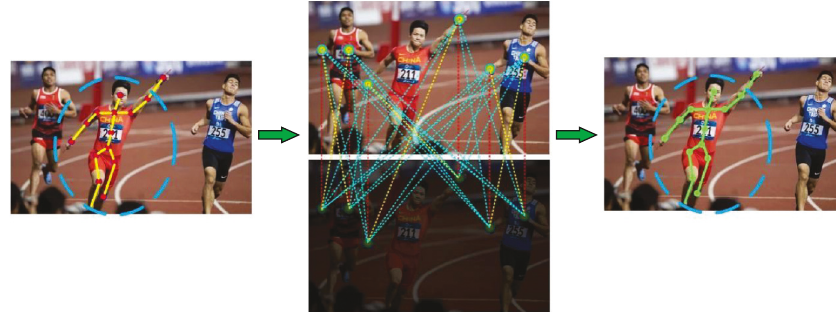
Figure 2: Confidence correlation process.